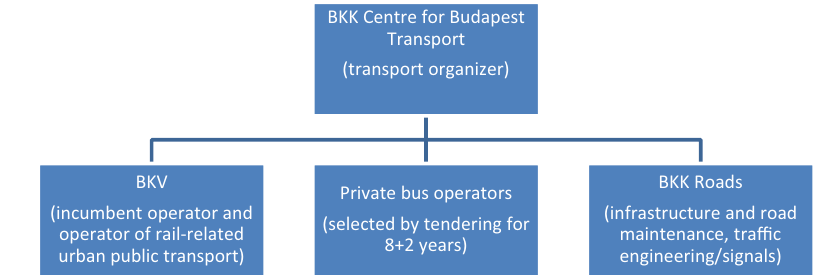
Fig. 6 Organizational structure of BKK Centre for Budapest Transport